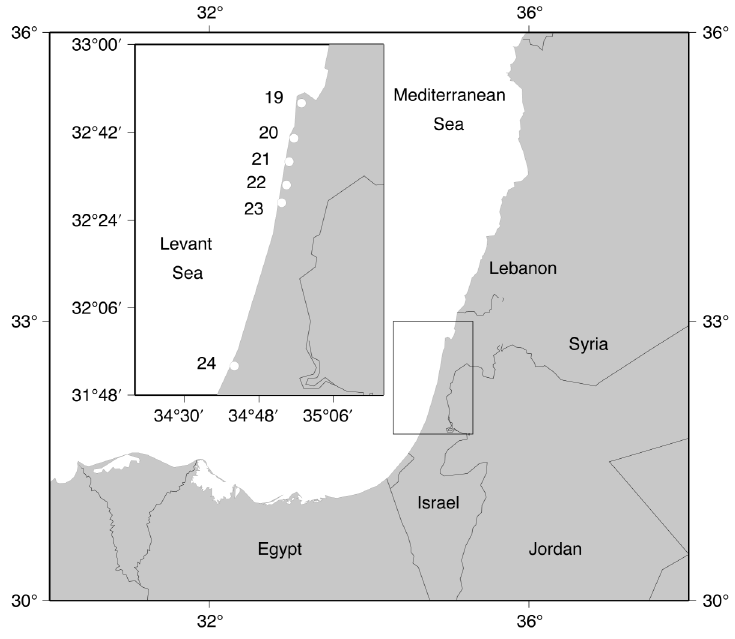
Fig. 14a. Sites along the coasts of Israel, ranging between Haifa (site 21) and Yavne Yam